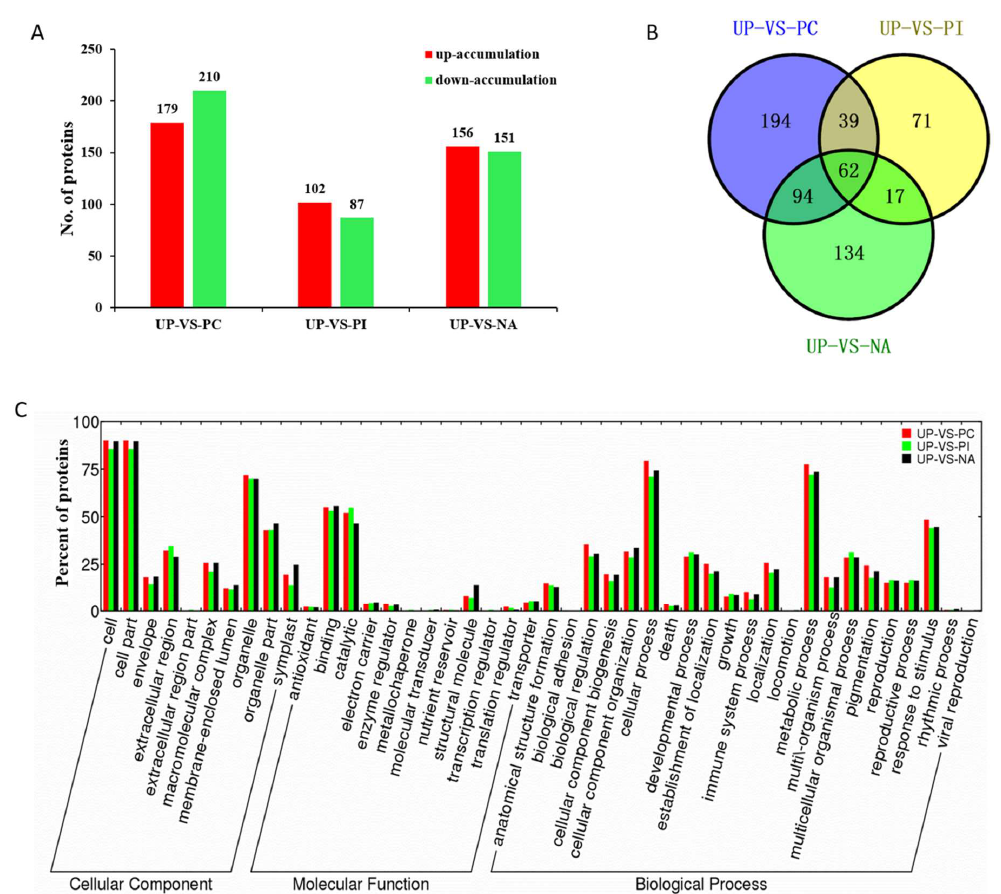
Figure 3. Functional classification of differentially accumulated proteins (DAPs) in UP-VS-PC, UP-VS-PI, and UP-VS-NA. ( A ) The numbers of DAPs; ( B ) A Venn diagram of DAPs showing unique and shared protein species; and ( C ) The cellular component, molecular function and biological process of DAPs.